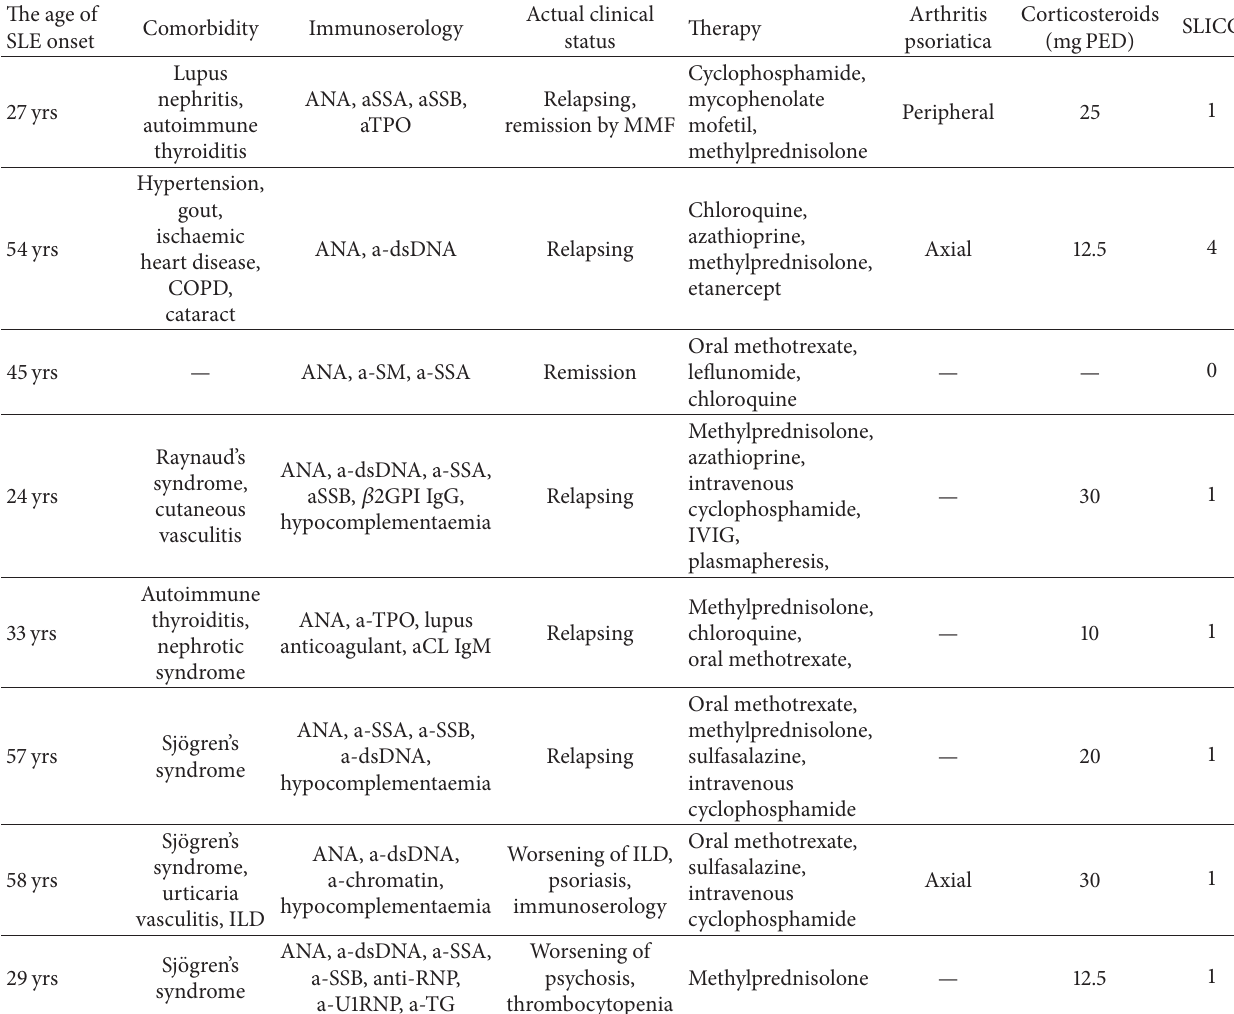
Table 3: Patient characteristics with SLE associated with